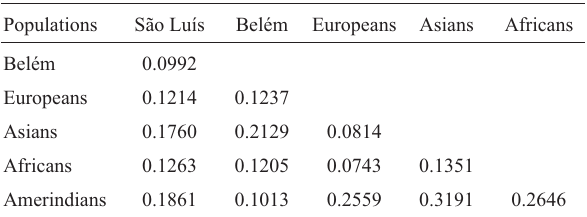
Table 2 - Genetic distance matrix calculated according to Nei et al . (1983). based on the allele frequencies for the vWA1. F13A1. Apo-B and D1S80